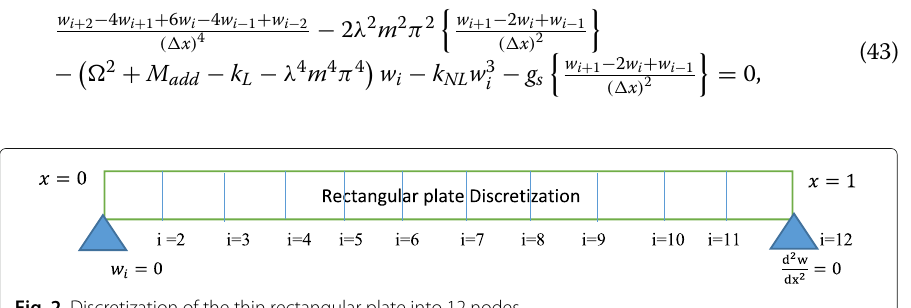
Fig. 2 Discretization of the thin rectangular plate into 12